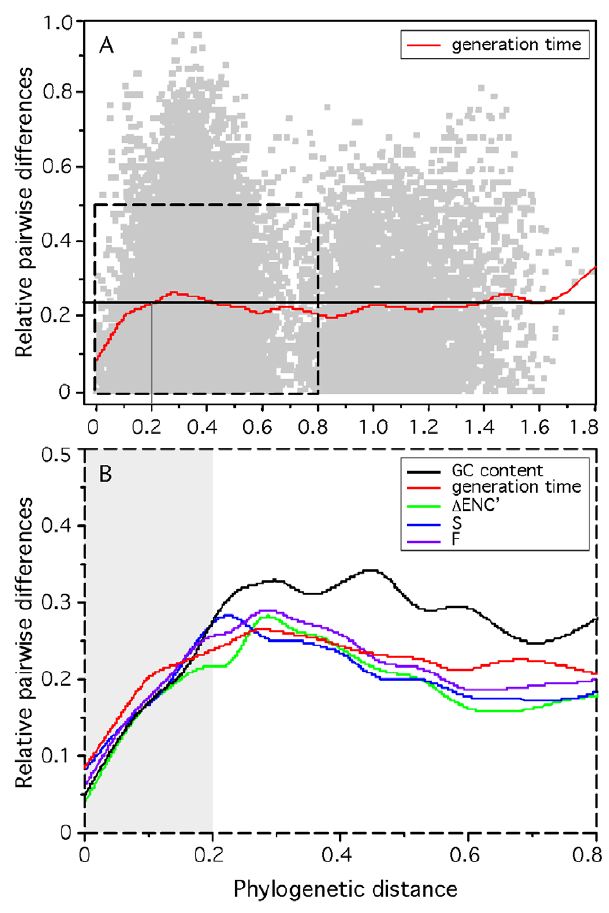
Figure 2. Relative difference between the minimum generation time, codon usage bias indices, and G + C content of pairs of organisms and their phylogenetic distance for 214 prokary- otes. Pairwise phylogenetic distances were computed from the matrix of the phylogenetic tree reconstruction (see Materials and Methods: phylogenetic analysis). Pairwise differences in doubling times (box-cox transform of d), codon usage bias indices D ENC 9 , S and F and G + C content were normalized by the maximum observed difference in the 22791 pairs dataset (eq. 10). (A) The datapoints are represented in light gray. The red line represents a flexible spline fit ( l =0.01). The black horizontal line represents the average relative pairwise difference. (B) The lines represent a flexible spline fit ( l =0.01). For short distances (light gray area), the spearman correlations between phylogenetic distance and the relative difference in minimal generation times, D ENC 9 , S and F and G + C content are respectively: 0.21, 0.28, 0.28, 0.29, 0.26 (all p-values ,